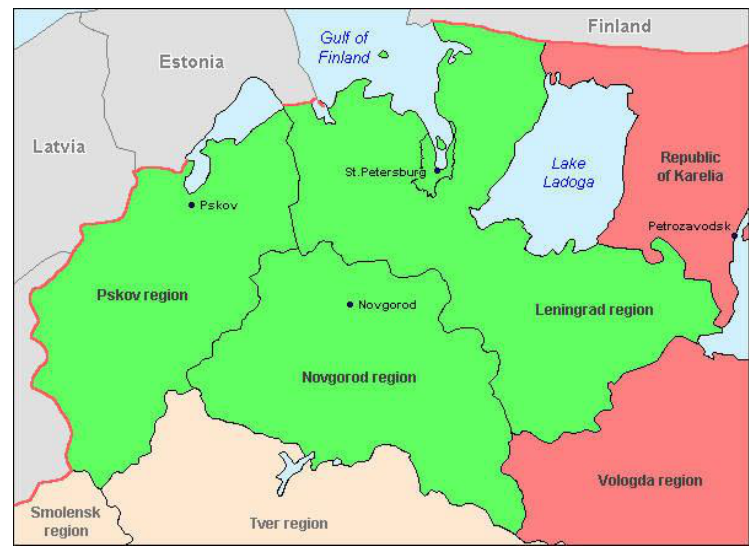
Figure 1. Location of the North-Western Region of Russia.